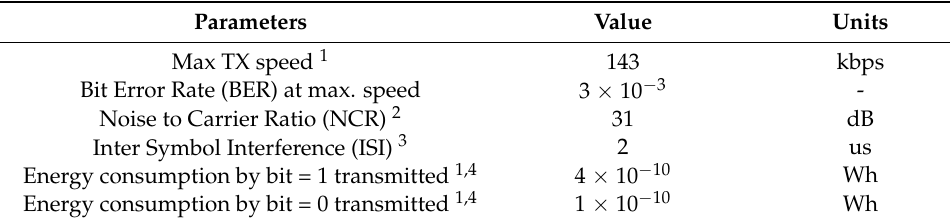
Table 1. Prototype communication parameters.